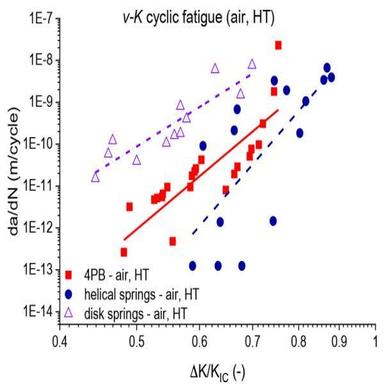
Crack propagation rate curves (v-K) obtained from HT tests on bend bars in 4PB, helical springs and disk springs.